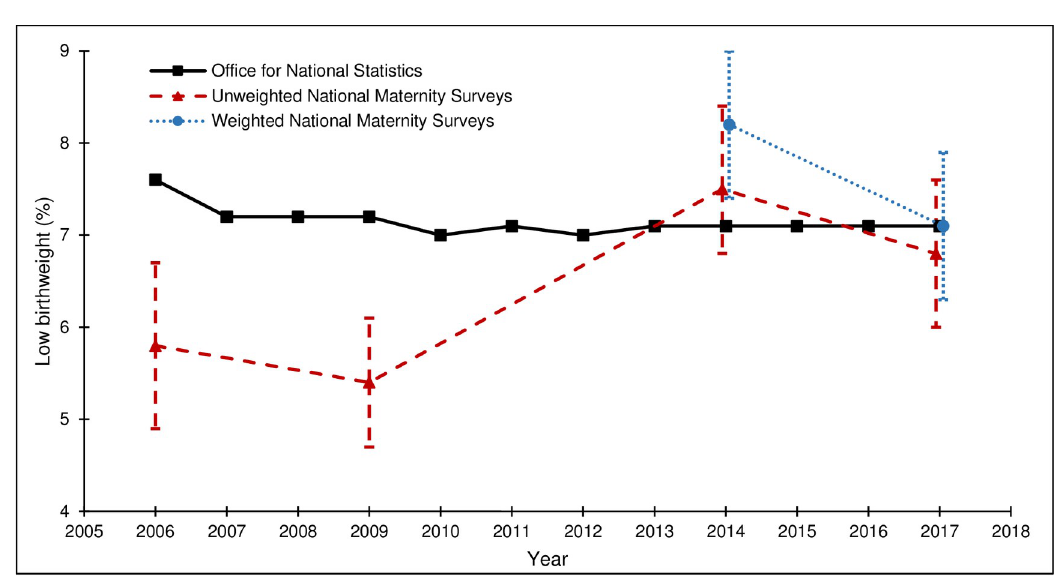
Fig 4. Low birthweight rates from the national maternity surveys^ and ONS. ^ Women gave birth in 2009, survey conducted in 2010; Women gave birth in 2017, survey conducted in 2018.